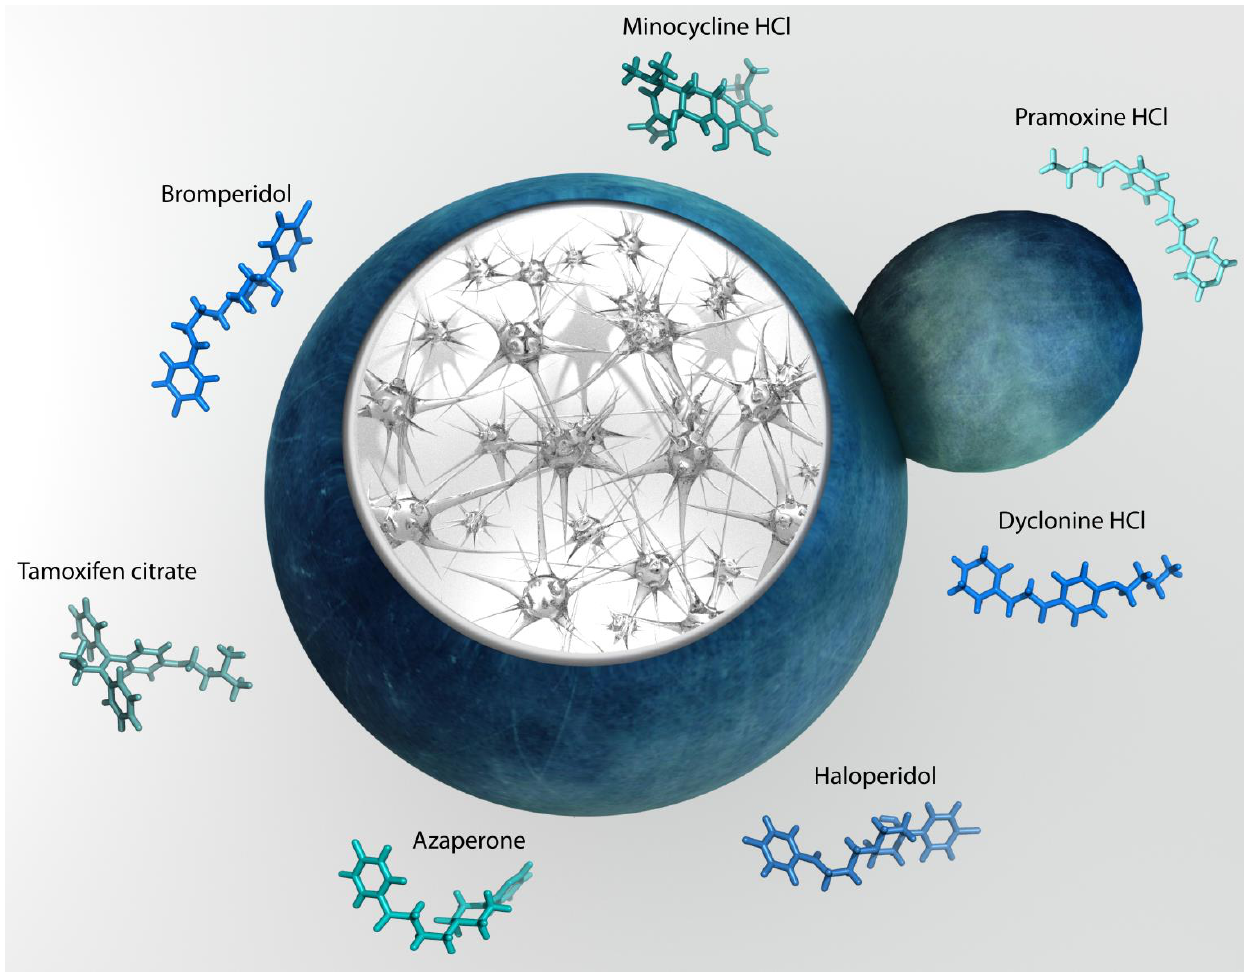
FIGURE 1: Yeast provide insight into molecular pathogenesis of Alzheimer disease and reveal modifiers of amyloid beta